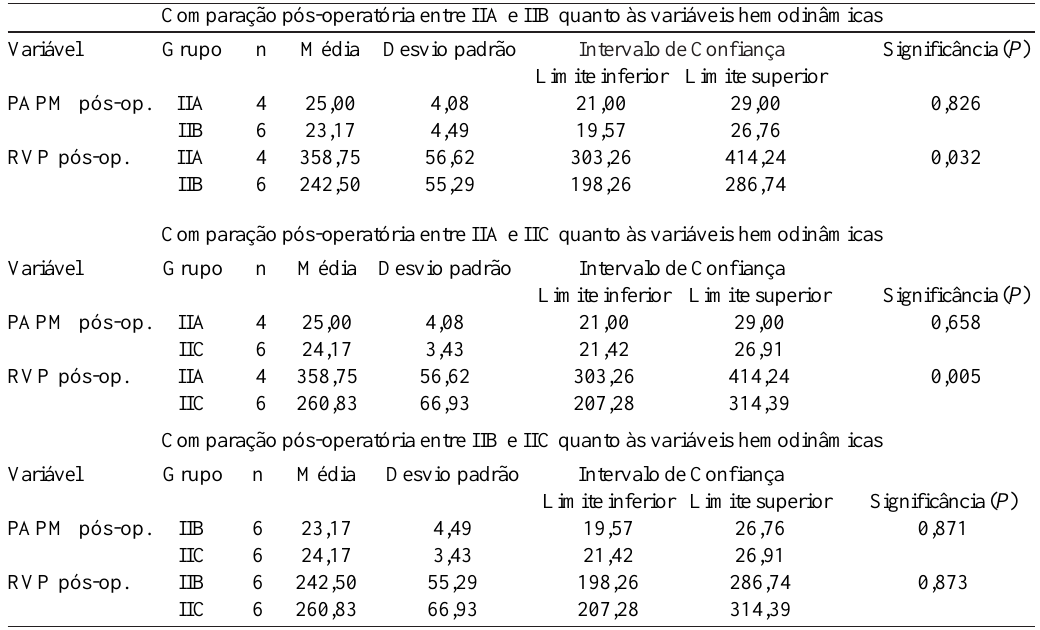
Tabela 2. Comparação pós-operatória entre subgrupos do grupo II quanto às variáveis hemodinâmicas